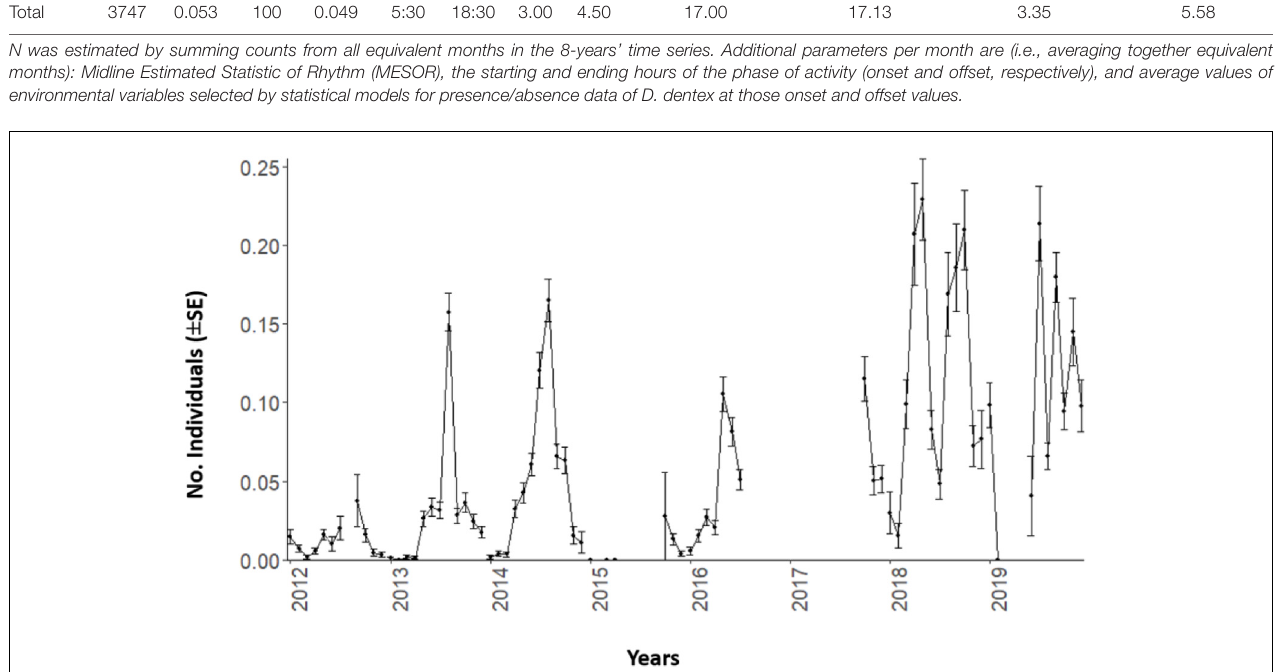
Irr. Water Temp. Water Temp. onset offset onset offset